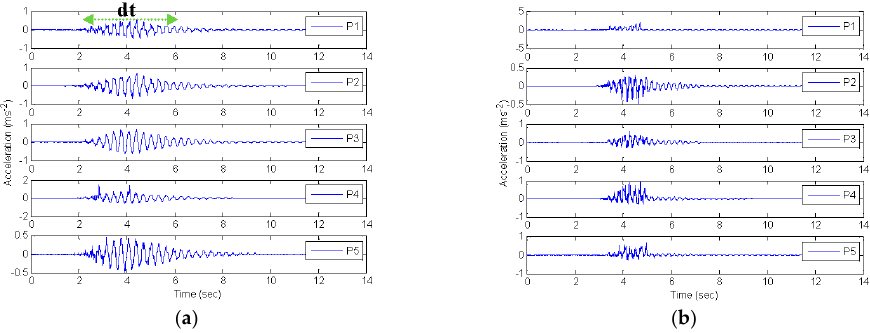
Figure 4. Vertical acceleration time histories of the girder caused by a high-speed train. ( a ) passage response points for 290 km/h; ( b ) passage response points for 406 km/h.